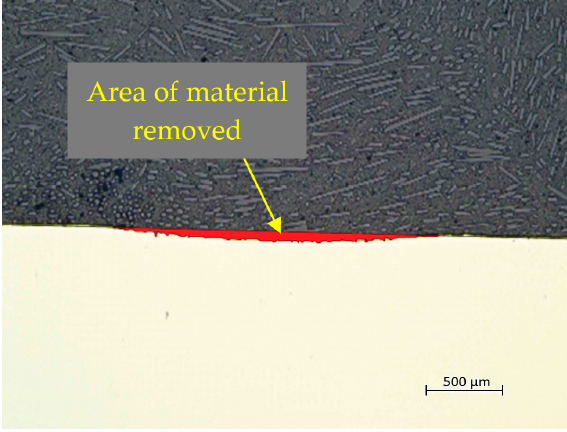
Figure 6. Groove created during the wear test with the marked area of removed material.